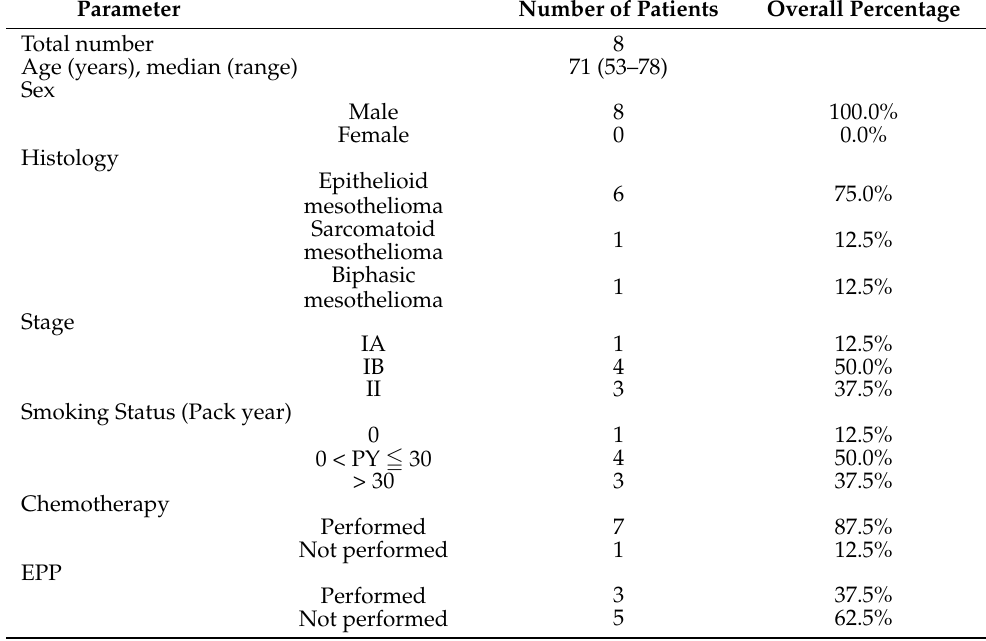
Table 1. Patient